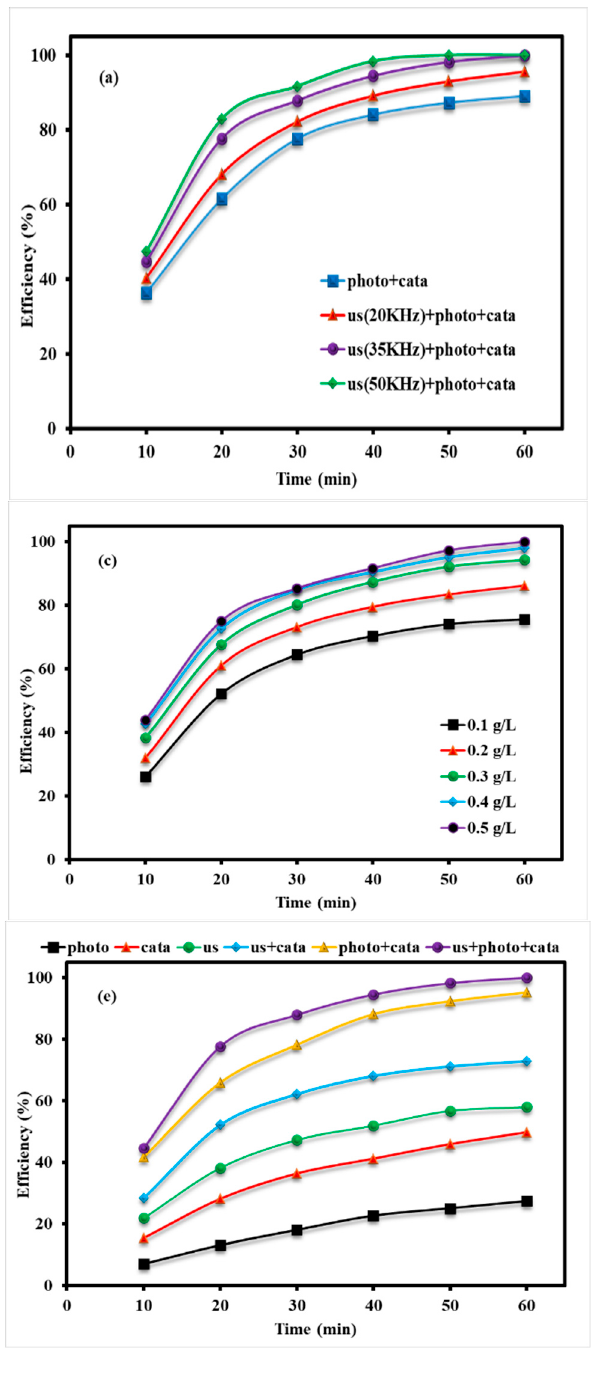
Figure 4. Results of the effect study of different parameters: ultrasonic wave frequency ( a ); UV light intensity ( b ); Fe 2 O 3 /g-C 3 N 4 dose ( c ); initial DZN concentration and contact time ( d ); comparison of the DZN removal efficiencies of the different evaluated treatment systems ( e ); and solution pH ( f ).